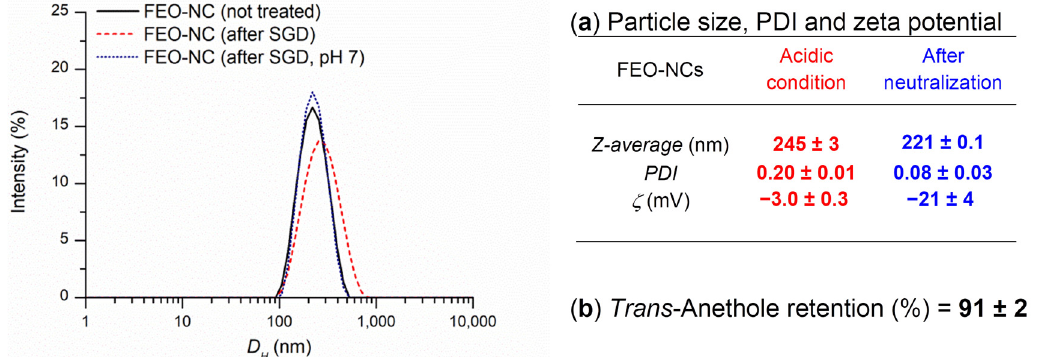
Figure 7. ( Left ) Intensity weighted particle D H (nm) distribution of FEO-NCs: not treated sample, after simulated gastric digestion (SGD), before and after neutralization. ( Right ) Physicochemical features after SGD ( a ); trans -anethole retention percentage after SGD ( b ).